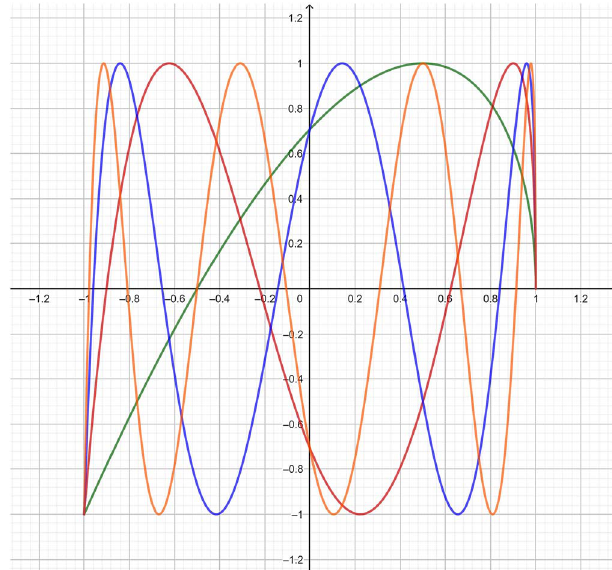
Figure 9. U k +1/2 ( x ), k = 1, 2, 3, 4. (1) Green; (2) red; (3) blue; (4)